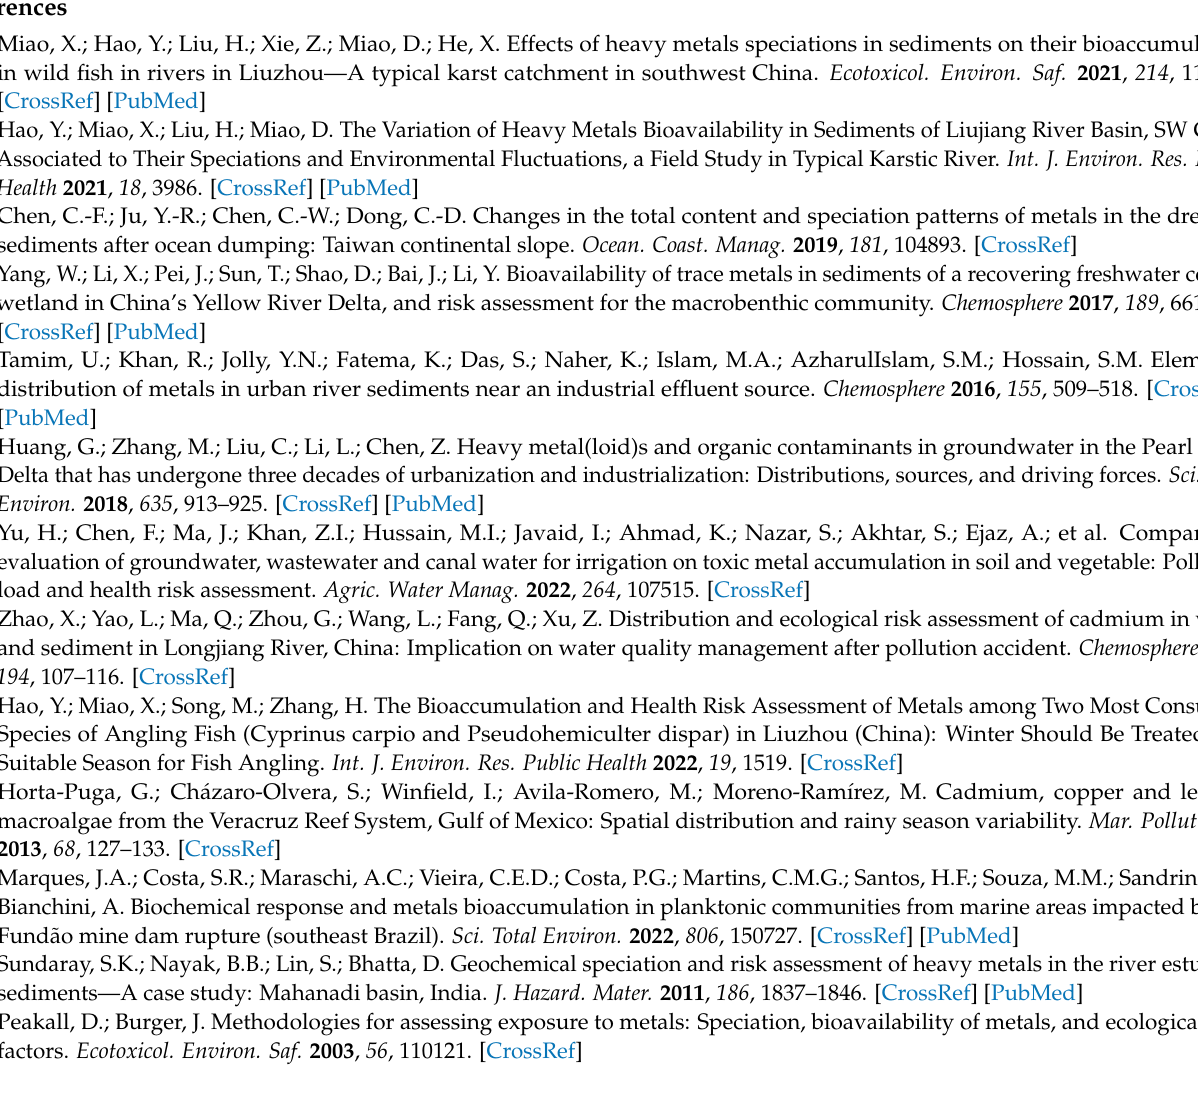
Table S1: The metals speciations of Liujiang River Basin in dry season; Table S2: The metals speciations of Liujiang River Basin in wet